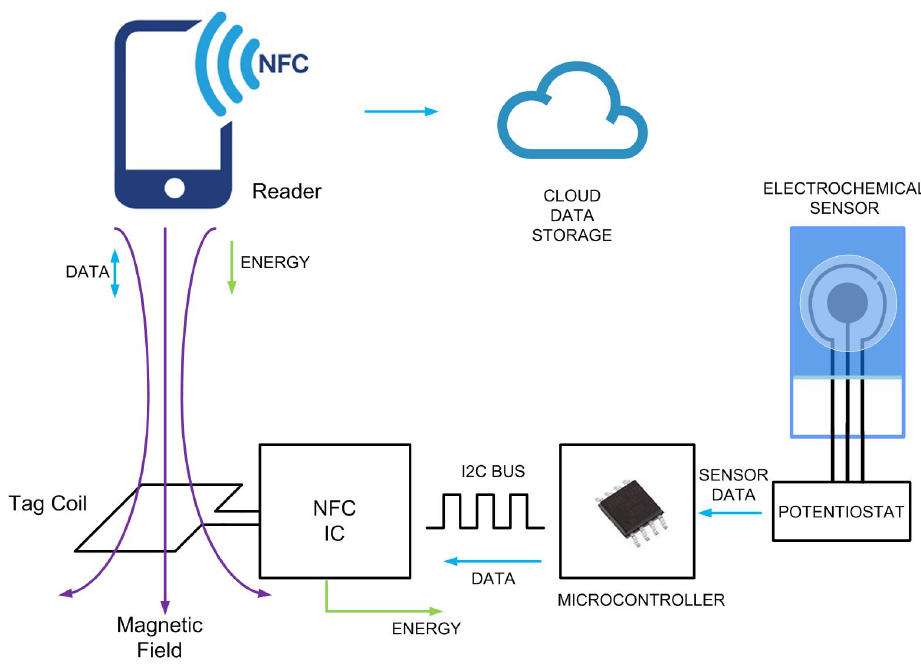
Figure 4. Scheme of the